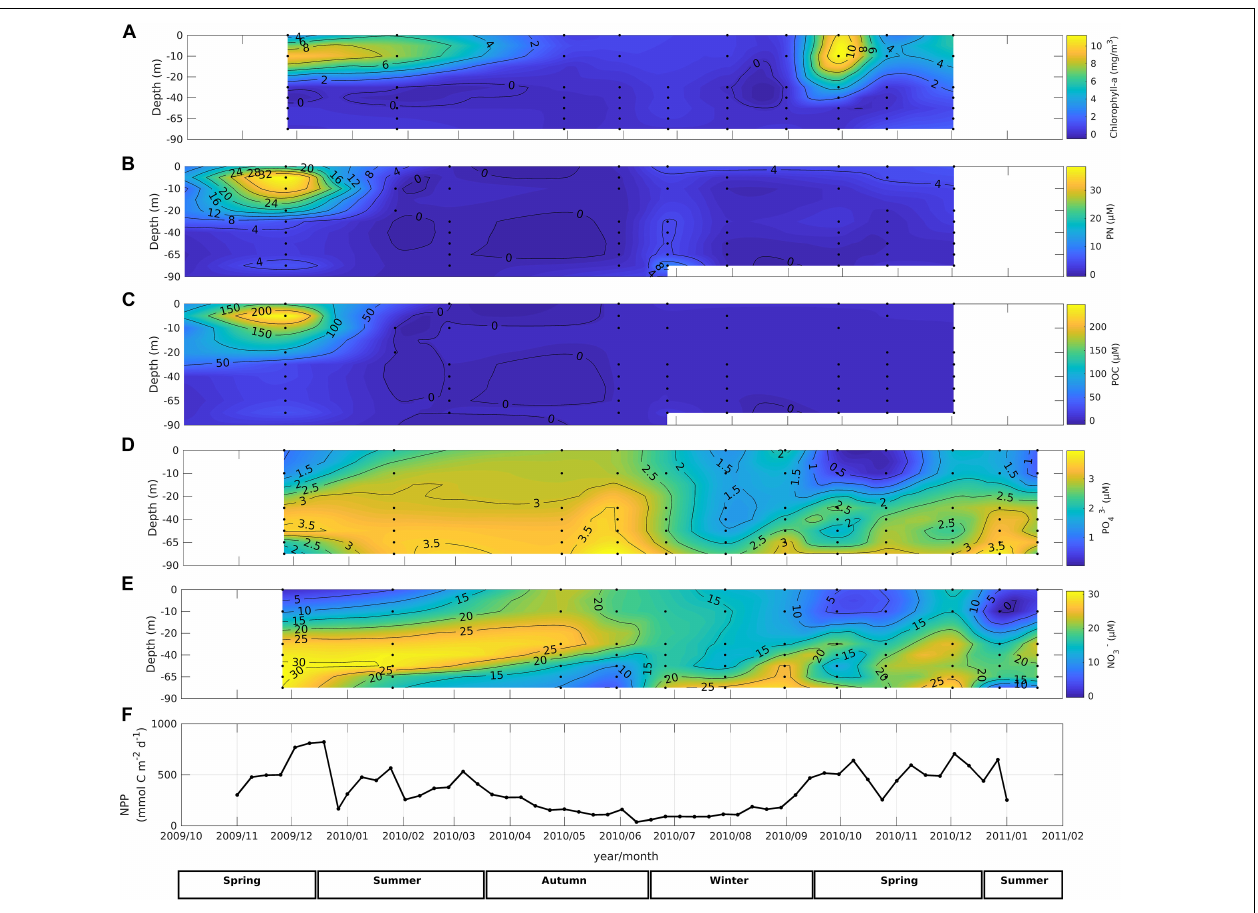
FIGURE 5 | Time series data from November 2009 through January 2011 in the water column at Station 18 off Concepción; (A) chlorophyll- a , (B) particulate nitrogen, (C) particulate organic carbon, (D) phosphate concentration, (E) nitrate concentration, (F) rate of depth integrated net primary production